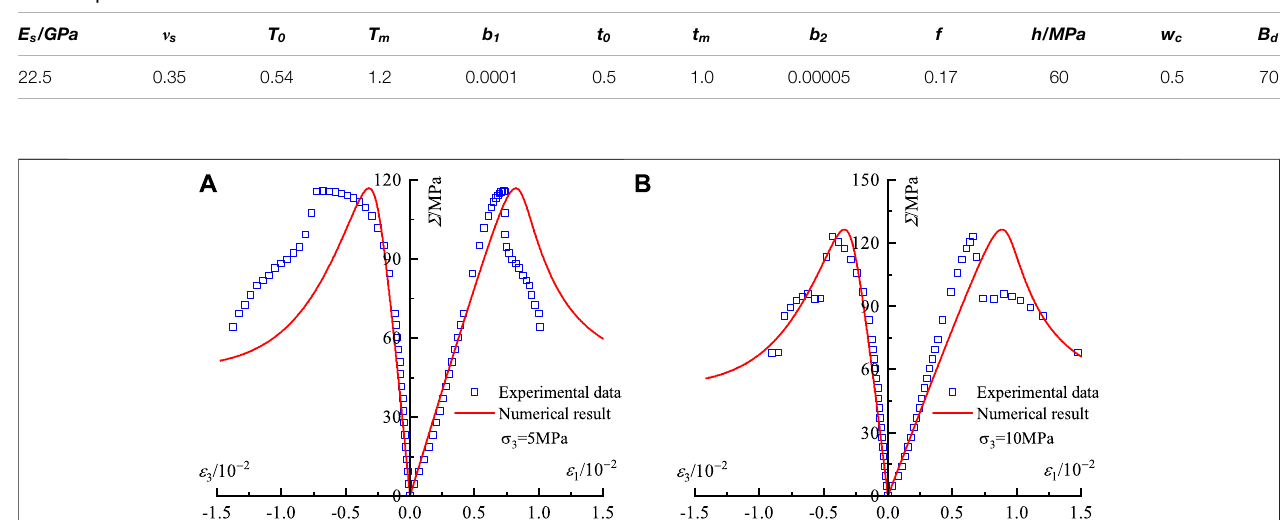
FIGURE4| Comparisonofstress-straincurvesbetweennumericalresultsandexperimentaldataundertriaxialcompressiontest. (A) Con fi ningpressureof5 MPa. (B) Con fi ning pressure of 10 MPa.